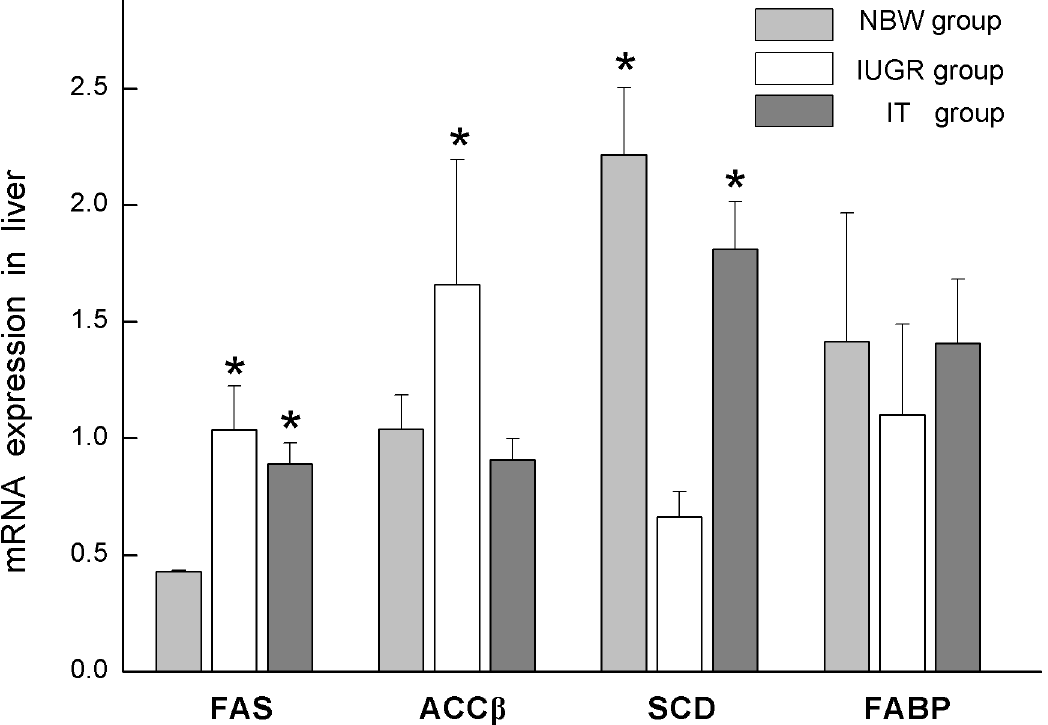
Fig 3. mRNA expression of FAS, ACC β , SCD, and FABP was normalized using GAPDH the control. Data are expressed as mean ± SEM, n = 6. SEM, standard error of mean. * indicates a significant difference from control group ( P < 0.05). NBW, piglets with normal birth weight that were fed with basic milk diets; IUGR: piglets with intrauterine growth retardation that were fed with basic milk diets; IT, piglets with intrauterine growth retardation that were fed with diets supplemented with 0.1% tributyrin.